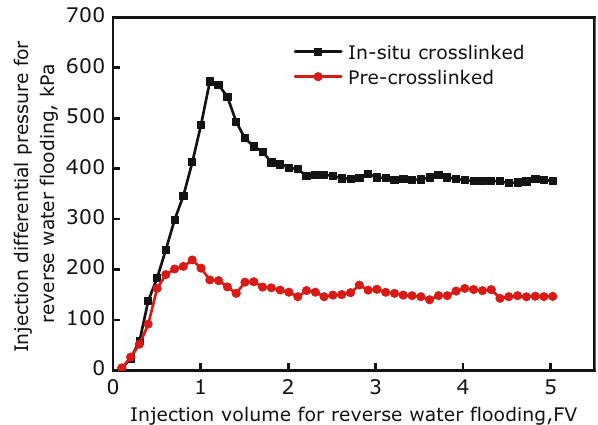
Figure 12: Di ff erential pressures for reverse water fl ooding after gelling in the case of in situ cross - linking and pre - cross -